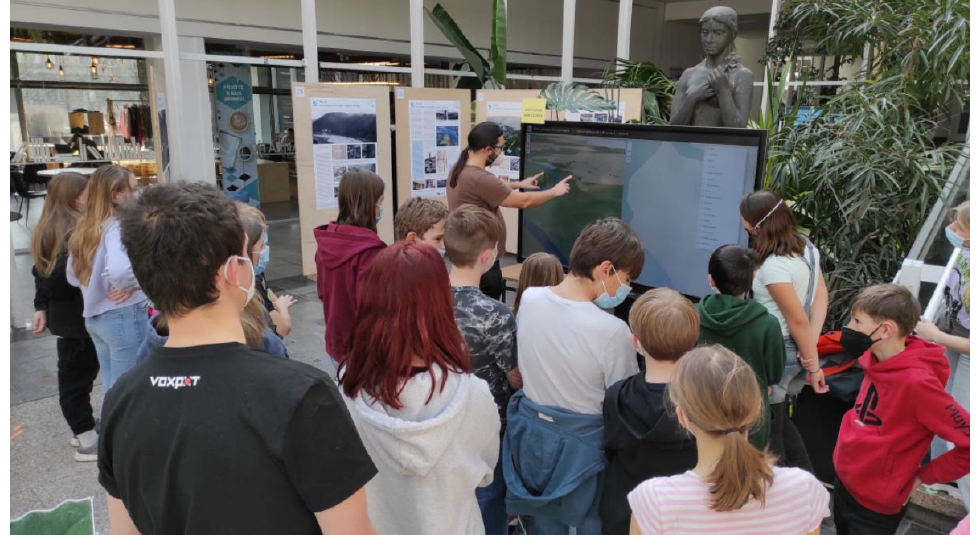
Figure 17. Using a touch screen to control a 3D web map during a tour of an elementary school at the exhibition Vltava—Transformations of the Historical Landscape.